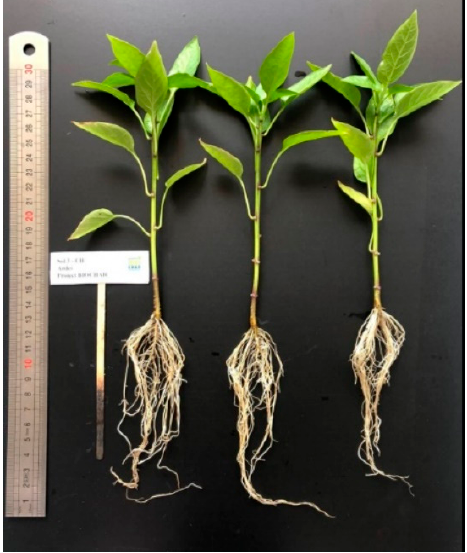
Figure 5. Images of bell pepper plants (root, stem, and leaves) grown for 109 days in BC-amended strongly acidic soil S3 (luvisol) without foliar treatment (S3 + BC). strongly acidic soil S3 (luvisol) without foliar treatment (S3 +